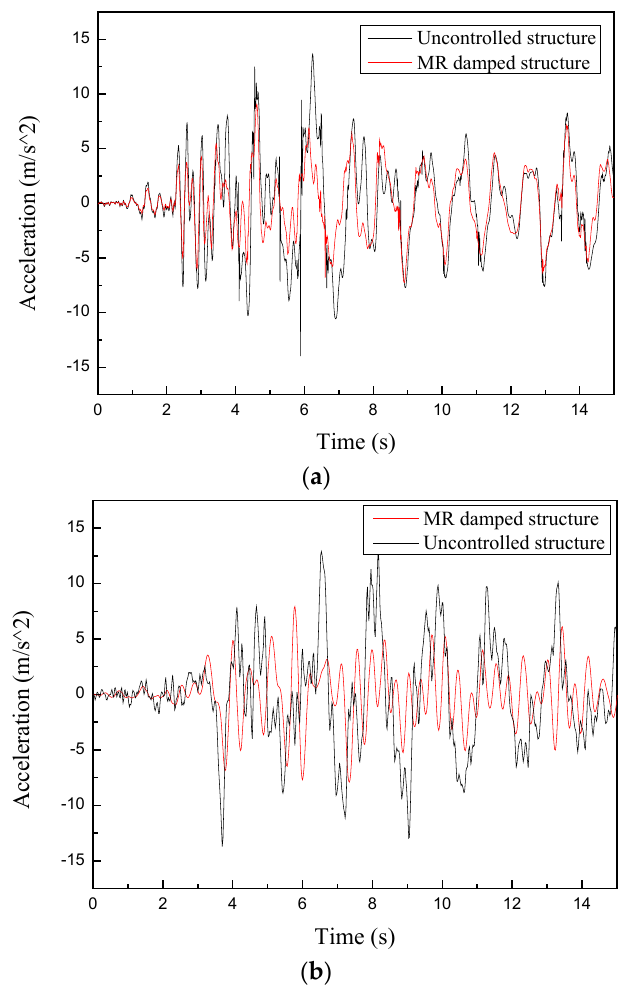
Figure 12. Acceleration time history responses of the uncontrolled and MR damped structure. ( a ) El Centro. ( b ) Taft.